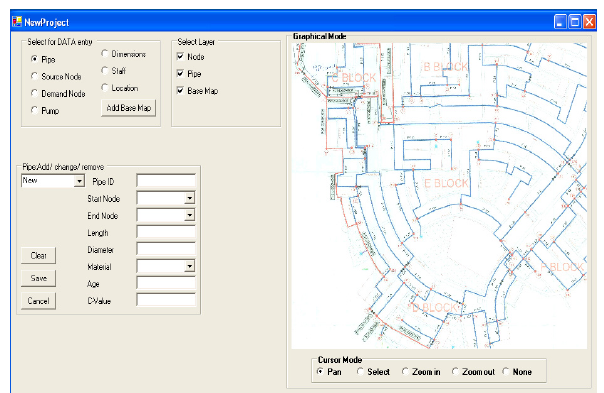
Fig. 10. Working of CLIPS for Sub-ModuleII Fig. 8. Different modules of Daily Run Module